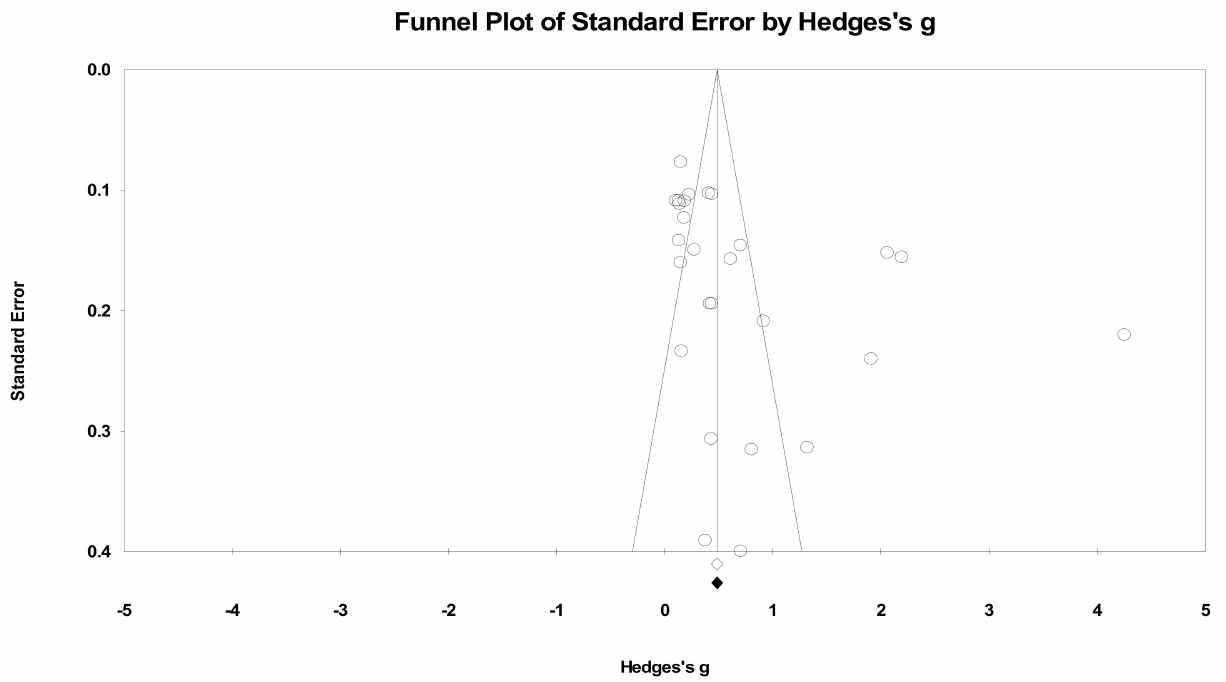
Figure 2. Funnel plot of systolic blood pressure by Hedges’ g (plot observed and imputed), random effects model. Notes. Summary effect size ( ◇ ); Summary effect size of imputed studies ( ◆ ); Individual studies ( ○